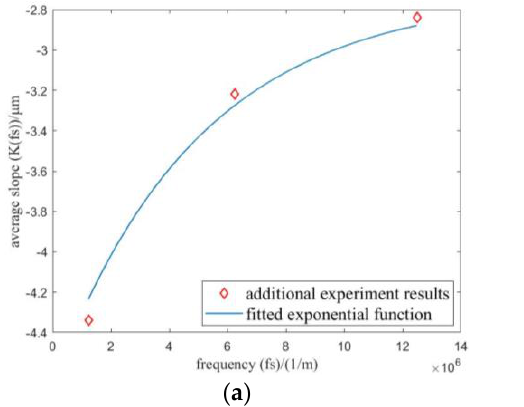
Figure 11. Experiment results and fitted exponential function (9Cr18Mo). ( a ) slopes; ( b ) intercepts.